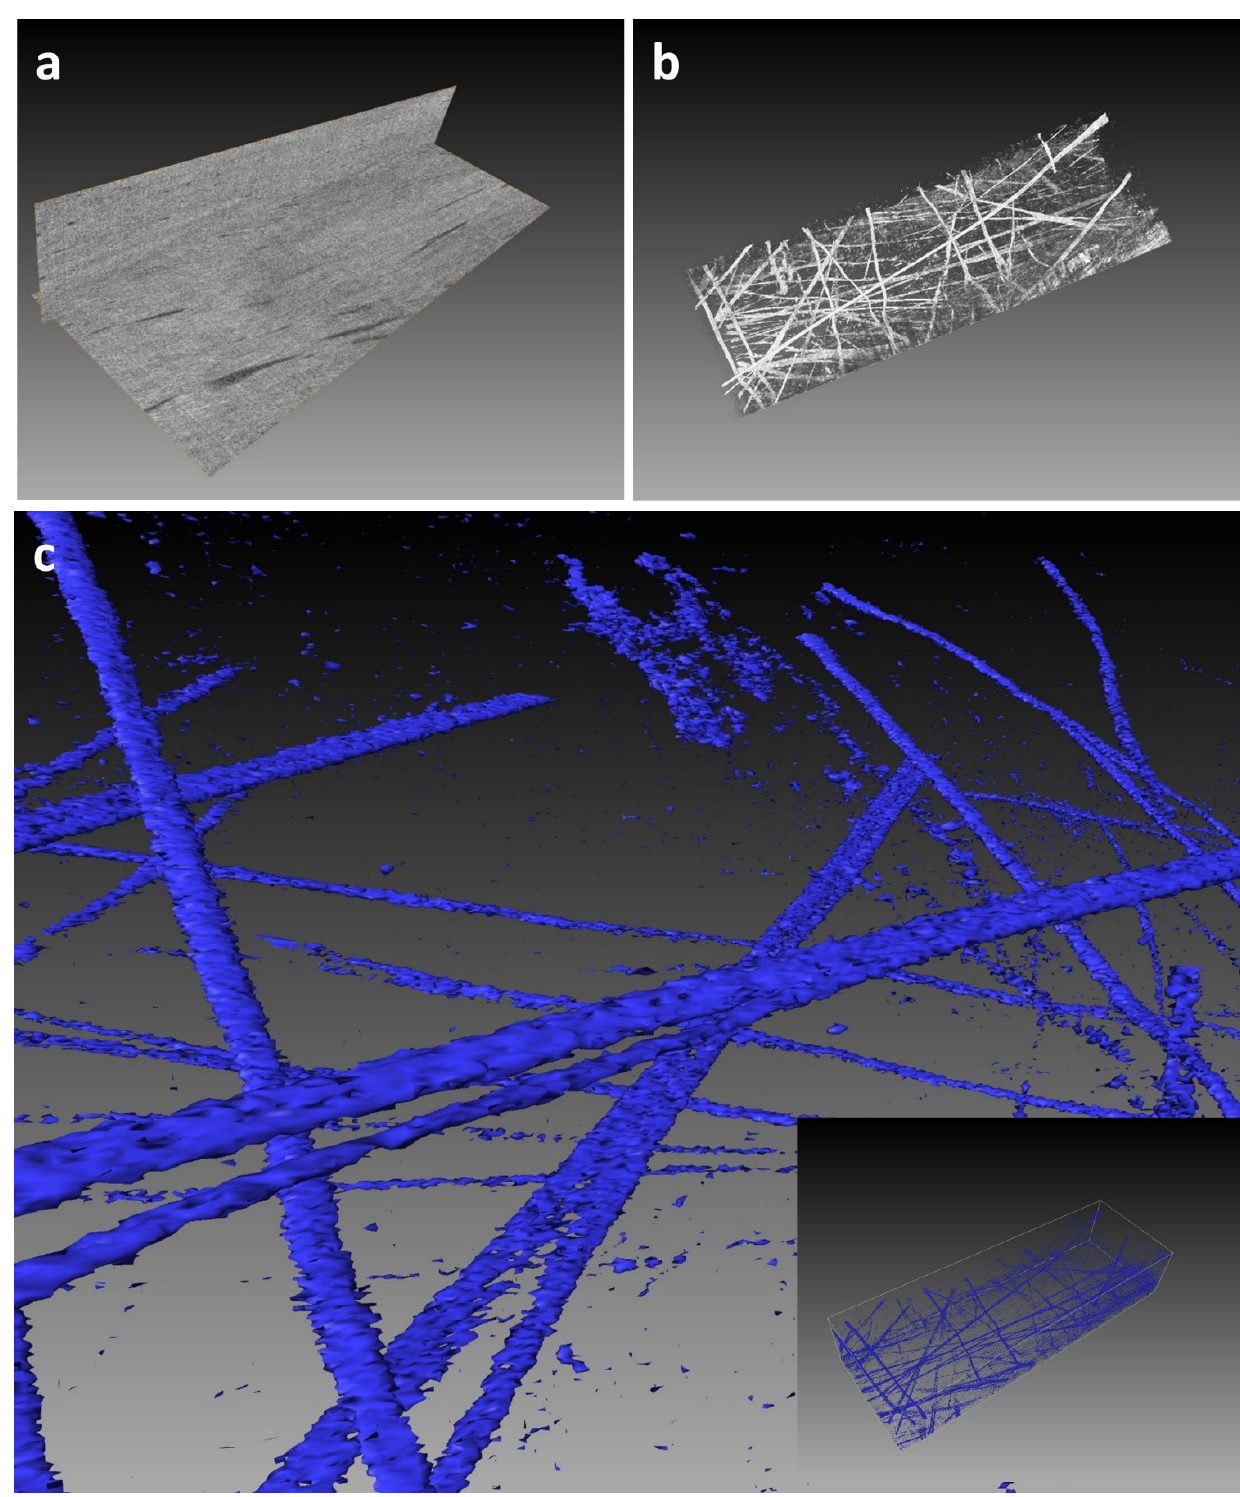
Figure 3. SBF SEM image data volume (50 × 25 × 15 microns) from human peripheral corneal stroma. The peripheral cornea stroma comprises an ECM of type I and V hybrid collagen fibrils and true elastic fibrillin-rich fibres [15]. ( a ) illustrates the presence of darkly stained elastic fibres within the volume. ( b ) Volren auto-rendering reveals the highly complex 3D arrangement of the fibres (white). ( c ) Iso-surface rendering of the elastic fibres (blue) highlights how the fine bifurcated, morphology of individual elastic fibres at nanometer resolution can be observed using the rendering